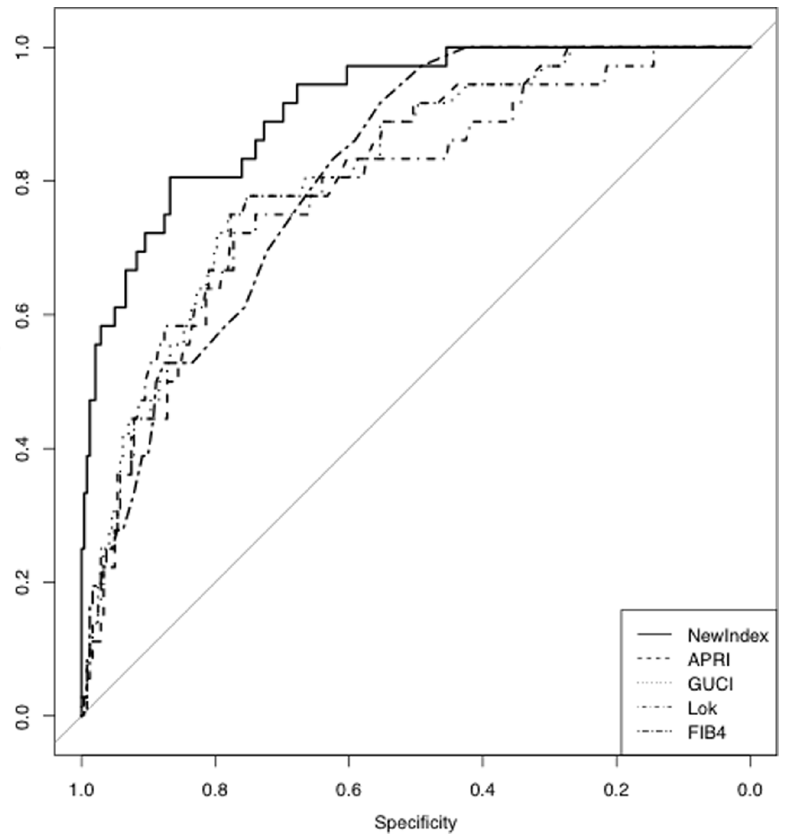
Figure 2. Receiver operator characteristics curves plotting sensitivity against specificity for prediction of cirrhosis in the exploratory set (n=278) for the new index (NoLI) in comparison with some other biochemical indices. The AUROC for NoLI was 0.91 (95% CI 0.86–0.96). The corresponding AUROC for the other indices in the exploratory set were for FIB4 0.81 (95% CI 0.75–0.87), Lok 0.79 (95% CI 0.71– 0.87), APRI 0.81 (95% CI 0.74–0.88), and for GUCI 0.81 (95% CI 0.74–0.88).